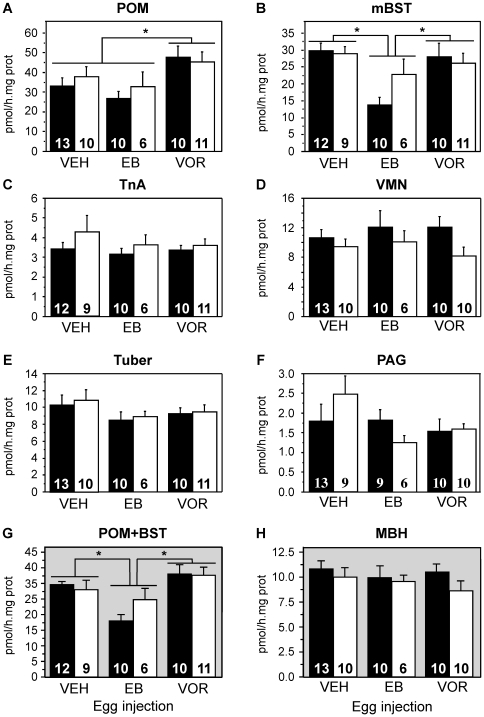
Effect of embryonic treatments with estradiol benzoate (EB) or Vorozole (VOR) on aromatase activity (AA; mean ± SEM) in the brain of adult gonadectomized male (black bars) and female (white bars) quail that were treated as adults with exogenous testosterone.Figures in the bars represent the numbers of final data points available for each group. Results for each nucleus were analyzed by a two-way ANOVA with the sex of the birds (Sex) and their embryonic treatment (TRT) as factors. Interactions (INT) between these factors were also evaluated. Data are illustrated for A) the medial preoptic nucleus (POM; Sex: F1,54 = 0.382, p = 0.539, TRT: F2,54 = 5.093, p = 0.009, Int: F2,54 = 0.355, p = 0.703), B) the medial bed nucleus of the stria terminalis (mBST; Sex: F1,52 = 0.810, p = 0.372, TRT: F2,52 = 7.192, p = 0.002, Int: F2,52 = 1.870, p = 0.164), C) the nucleus taeniae of the amygdala (TnA; Sex: F1,53 = 1.408, p = 0.241, TRT: F2,53 = 0.791, p = 0.459, Int: F2,53 = 0.107, p = 0.899), D) the ventromedial nucleus of the hypothalamus (VMN; Sex: F1,53 = 4.252, p = 0.044, TRT: F2,53 = 0.170, p = 0.844, Int: F2,53 = 0.276, p = 0.760); E) the tuber (Sex: F1,54 = 0.230, p = 0.636, TRT: F2,54 = 1.640, p = 0.204, Int: F2,54 = 0.030, p = 0.975), F) the periacqueductal gray (PAG; Sex: F1,52 = 0.039, p = 0.844, TRT: F2,52 = 1.758, p = 0.183, Int: F2,52 = 1.360, p = 0.266), G) the POM and mBST together (Sex: F1,52 = 0.475, p = 0.494, TRT: F2,52 = 7.901, p = 0.001, Int: F2,52 = 1.162, p = 0.321) and H) the mediobasal hypothalamus (MBH = VMN+Tuber; Sex: F1,53 = 1.428; p = 0.237, TRT: F2,53 = 0.419; p = 0.660, Int: F2,53 = 0.271; p = 0.764). Origins of the main effects of TRT in the POM, mBST and POM+mBST were analyzed by post-hoc Fisher Protected Least Significance Difference tests. Results are reported at the top of the two columns as follows: * p<0.05 compared to different treatment in both sexes.